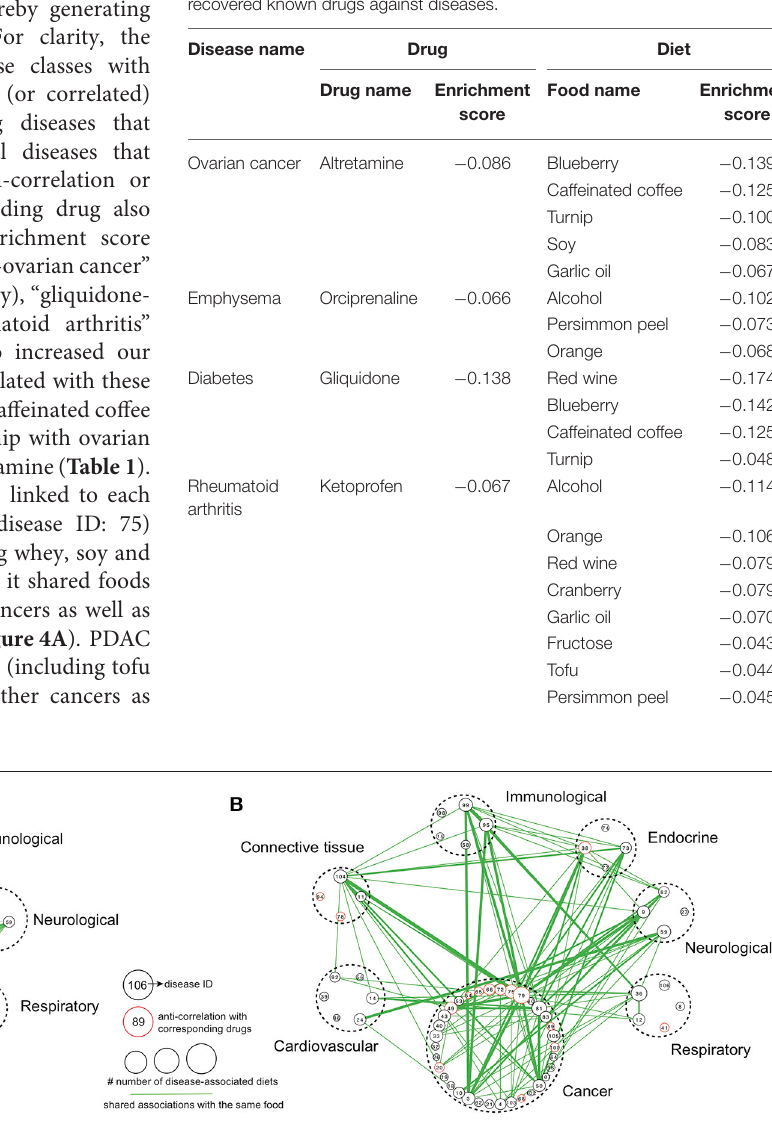
FIGURE 4 | Disease class-centric association networks. Disease class-centric association networks built based on shared foods with same (A) anti-correlation or (B) correlation. The size of each node is proportional to the number of diets showing anti-correlated or correlated relationships with the corresponding disease. Diseases classified into same disease class are encircled by a dashed line. Edges connect diseases that were anti-correlated (or correlated) with the same foods, and the edge thickness is proportional to the number of such common foods. Only disease classes that have at least three diseases showing anti-correlated (or correlated) relationships with diet and edges with at least 4 associated foods are shown